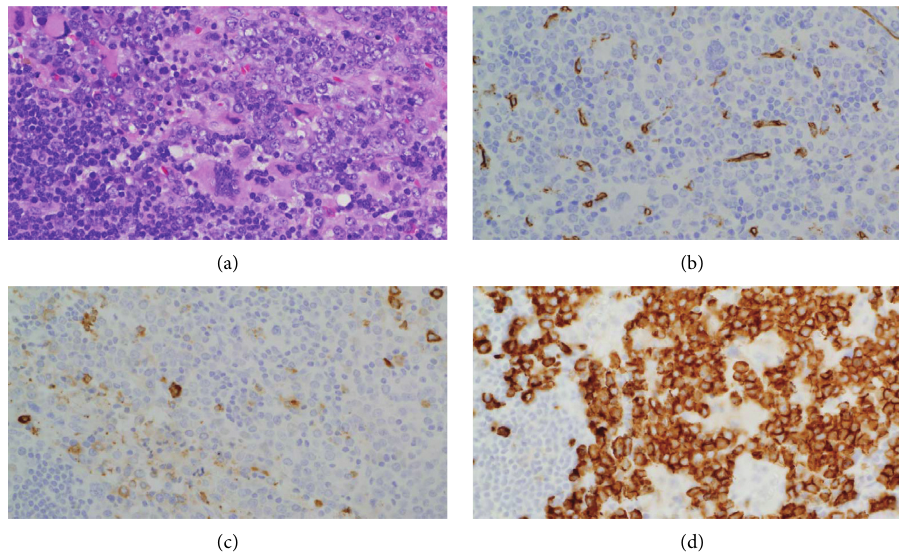
Figure 3: Lymph node showing extensive extramedullary involvement by a myeloproliferative neoplasm with numerous megakaryocytes ((a) hematoxylin and eosin stain, 400x), no increase in blasts ((b) CD34 immunostain, 400x), or significant myeloid cells ((c) MPO immunostain, 400x) but with prominent erythroid precursors ((d) CD71 immunostain,